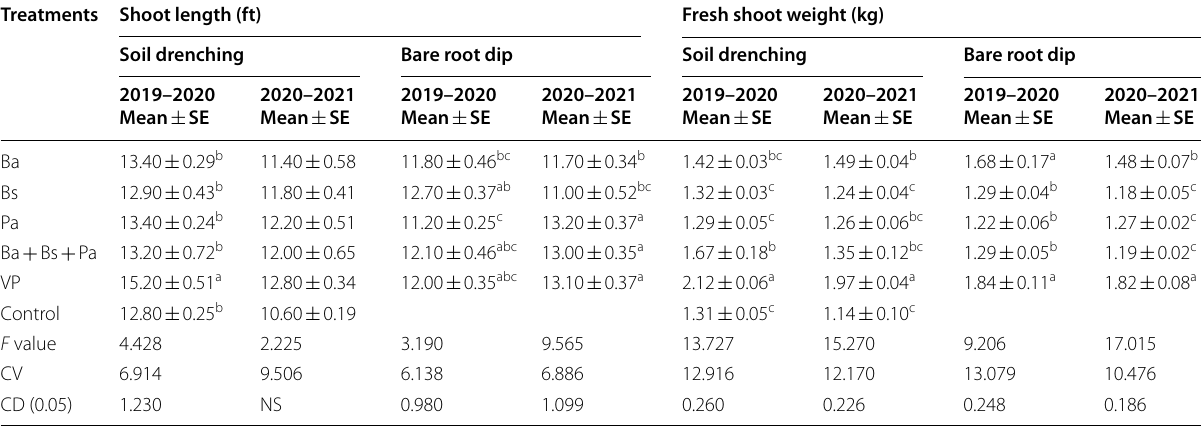
Data shown correspond to the mean of four replicates SE. Means with the same alphabet letters on each columns are not significantly ( P < 0.05 ) different ± CD critical difference, CV coefficient of variation, SE standard error. Treatment details: Ba Bacillus amyloliquefaciens DSBA 11, Bs Bacillus subtilis DTBS 5, Pa Pantoea agglomerans ; Ba Bs Pa (Consortium), VP Velum Prime ® (500 g a.i./ha) as positive + +